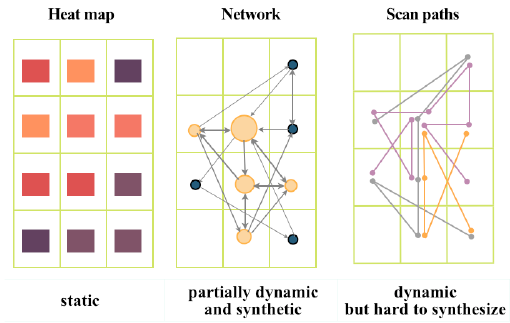
Figure 1. Three basic approaches